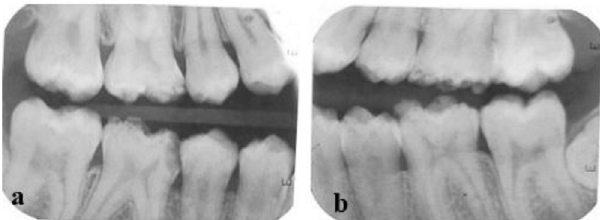
Fig. 2. Intra-oral periapical radiographs of left (a) and right (b) permanent fi rst molars revealing multiple irregular radiopaque projections of cusps on the occlusal aspect with carious